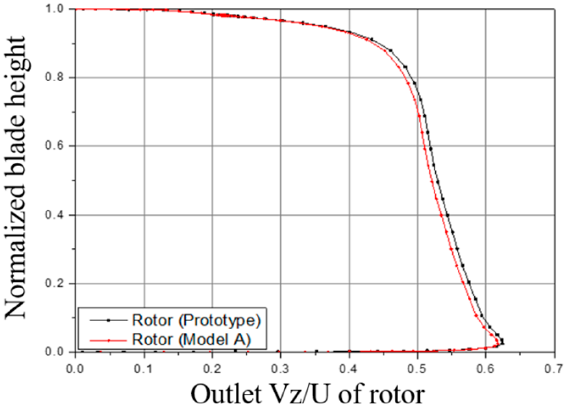
Figure 7. Averaged circumferential values of aerodynamic parameters of the rotor.